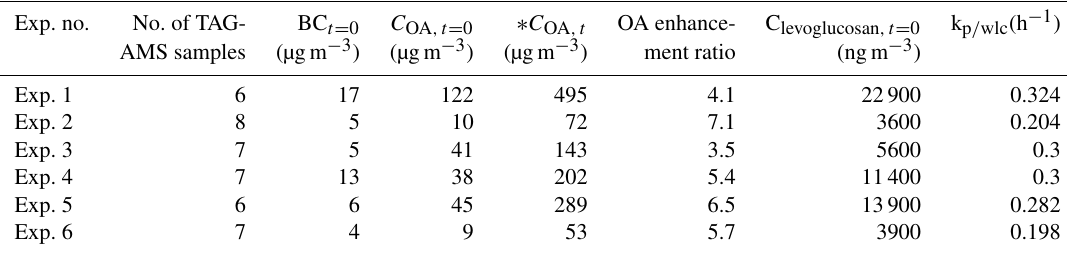
Table 1. Organic aerosol concentration before and after aging (corrected for particle wall loss), and levoglucosan concentration measured by TAG-AMS before